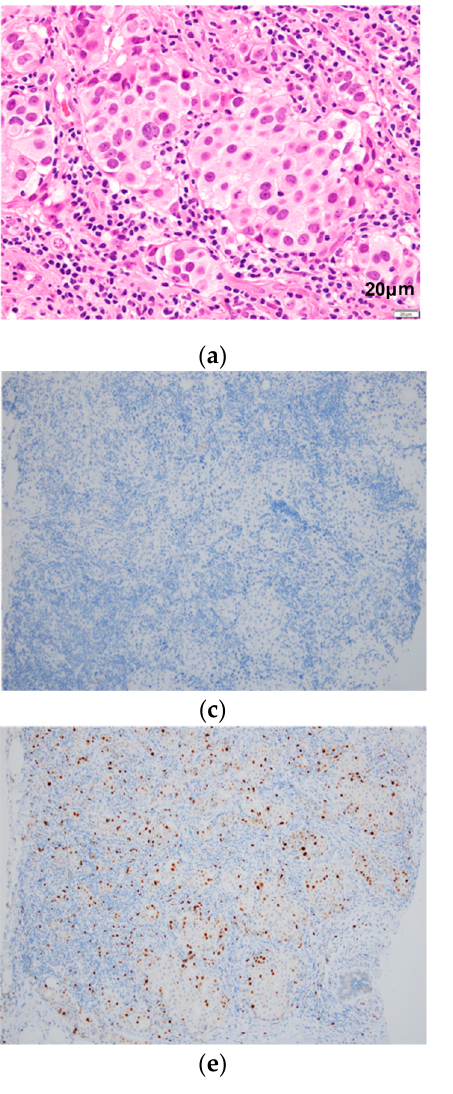
Figure 2. Pathology of breast lesion tissue sampled by ultrasound-guided biopsy. Histological examination reveals invasive ductal carcinoma, scirrhous type. HE staining ( a ); Immunostaining shows estrogen receptor [ER], Allred score 8 ( b ); progesterone receptor [PR], Allred score 2 ( c ); human epidermal growth factor receptor [HER2], score 3+ ( d ); and Ki-67, 10.5% ( e